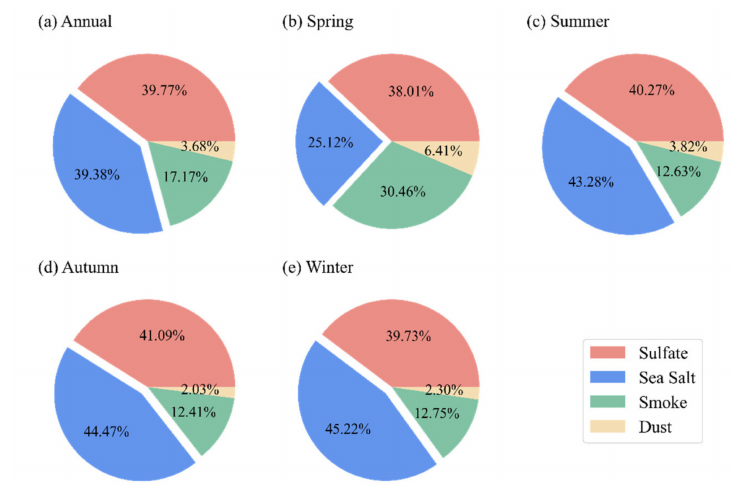
Figure 15. Annual and seasonal mean proportions of AOD by four components: sulfate (red), sea salt (blue), smoke (green), and dust (orange). Note these data are from MERRA-2. The fraction change in four components in the last ten years is exhibited in Figure 16.